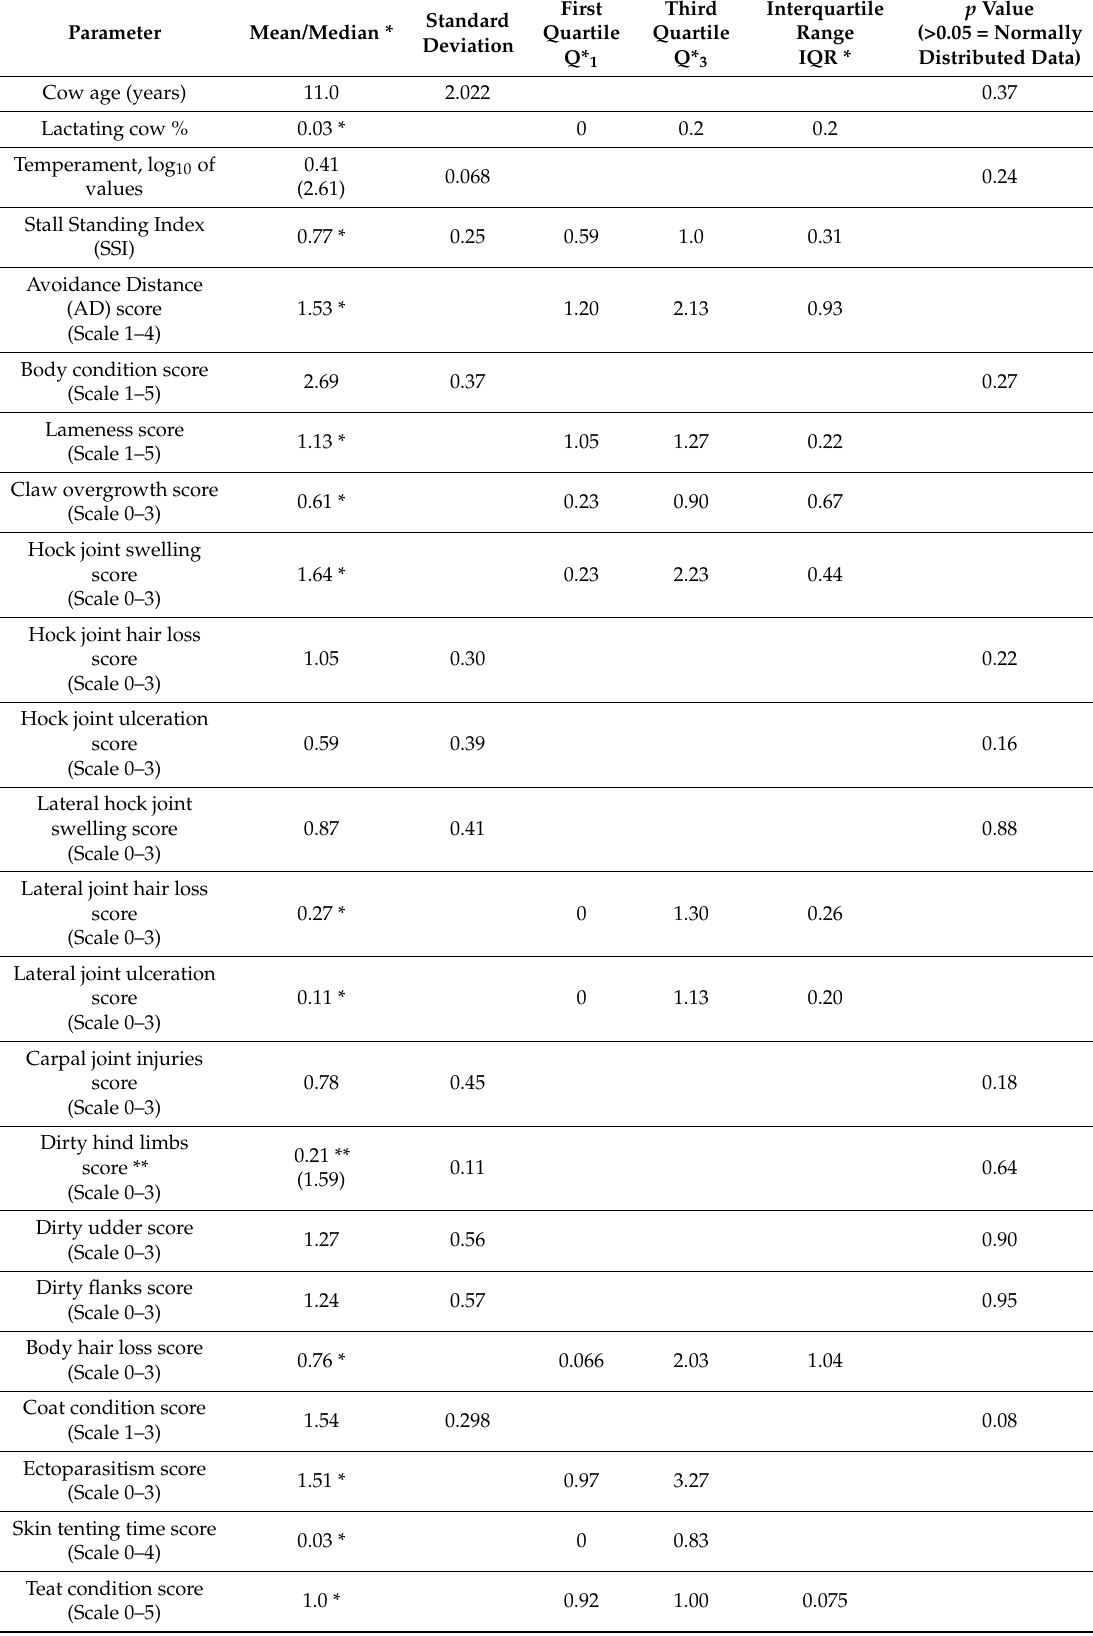
Table 4. Descriptive Statistics for animal-based measures in the cow shelters measured on ordinal as well as continuous